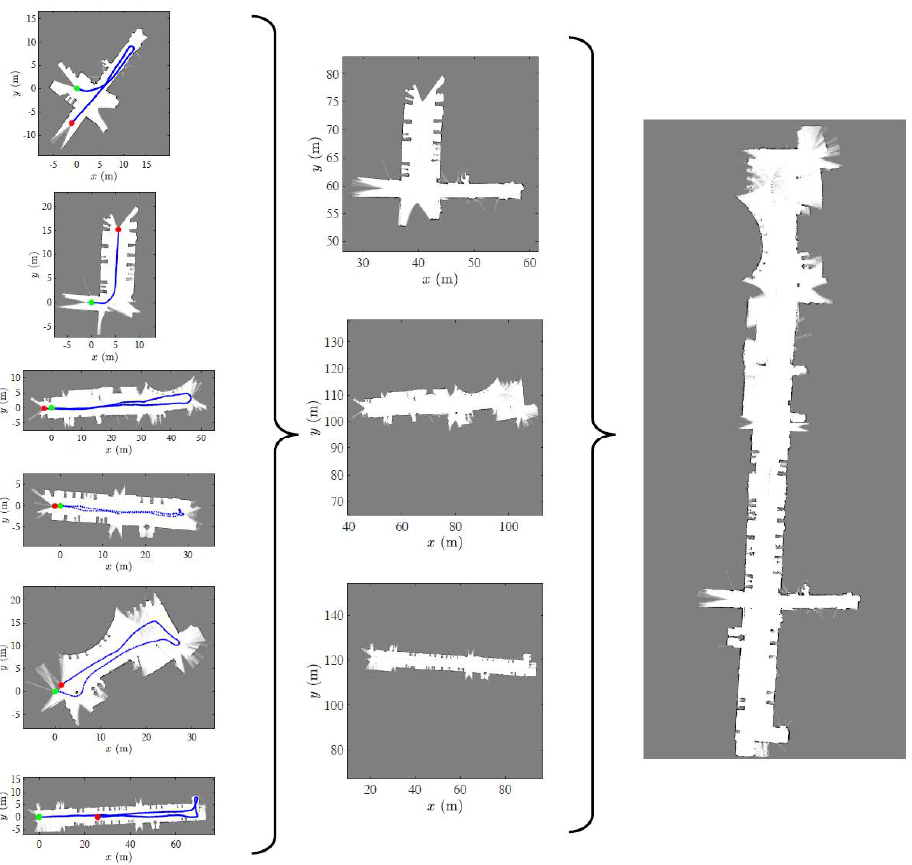
Figure 13. Map fusion hierarchy. The six heterogeneous local maps obtained from individual robots are hierarchically merged into a consistent global map.